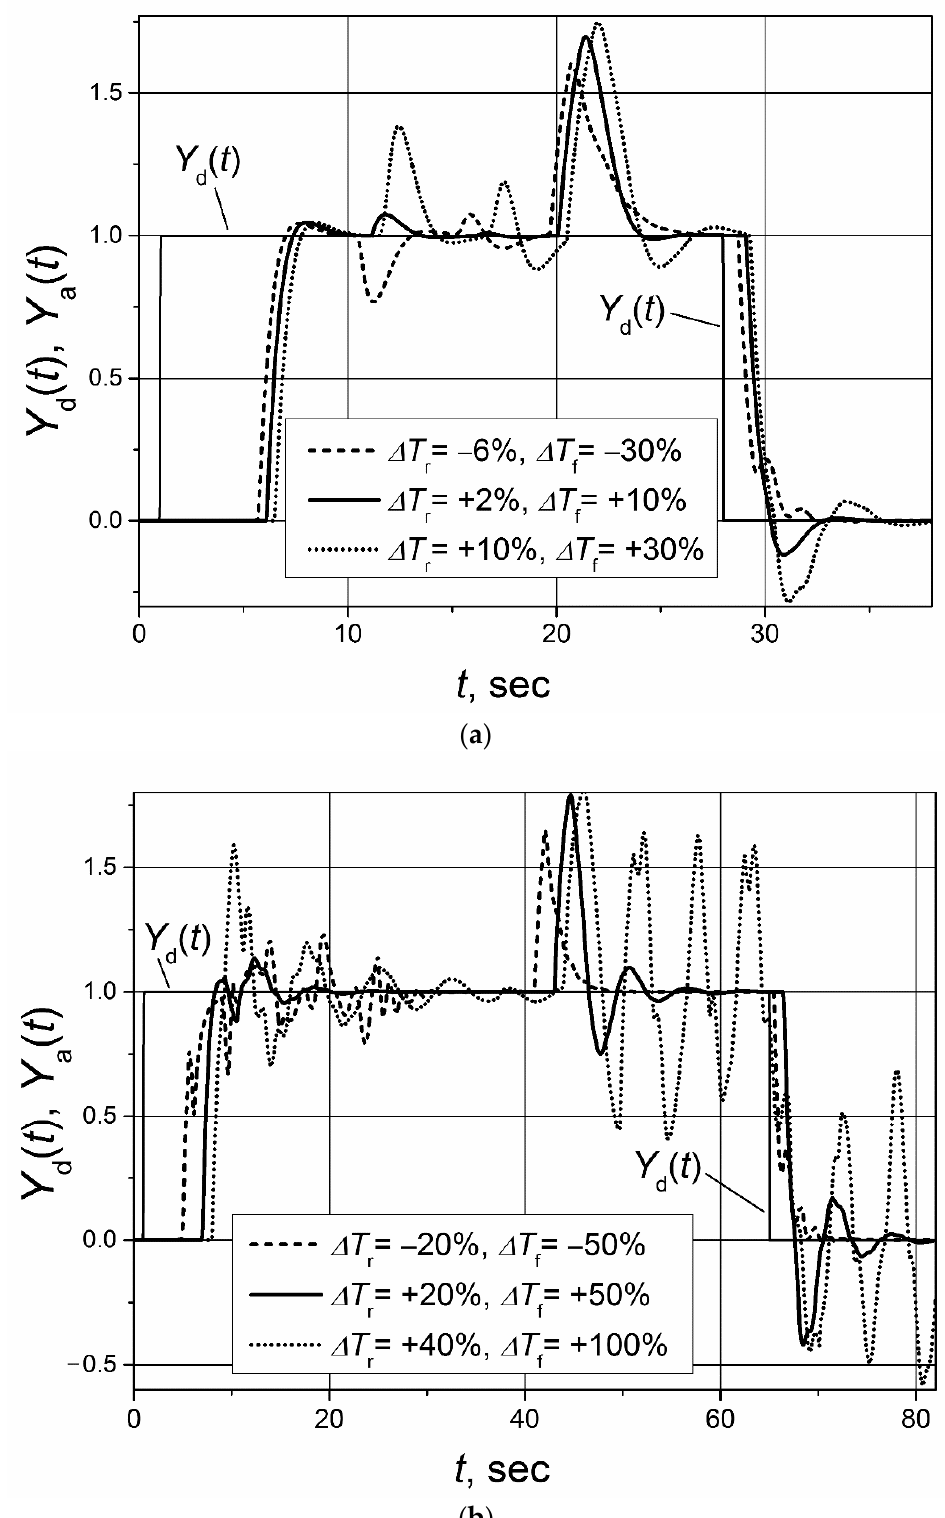
Figure 10. The set-point unit pulse and unit-load disturbance responses of the control system of the first-order plant with asymmetric response delay based on the PI controller with the switched-delay Smith predictor when both plant-response delays change: T r changes by value ∆ T r and T f by value ∆ T f . Unit-load disturbances occur at times: t = 15 s ( a ); t = 36 s ( b ).